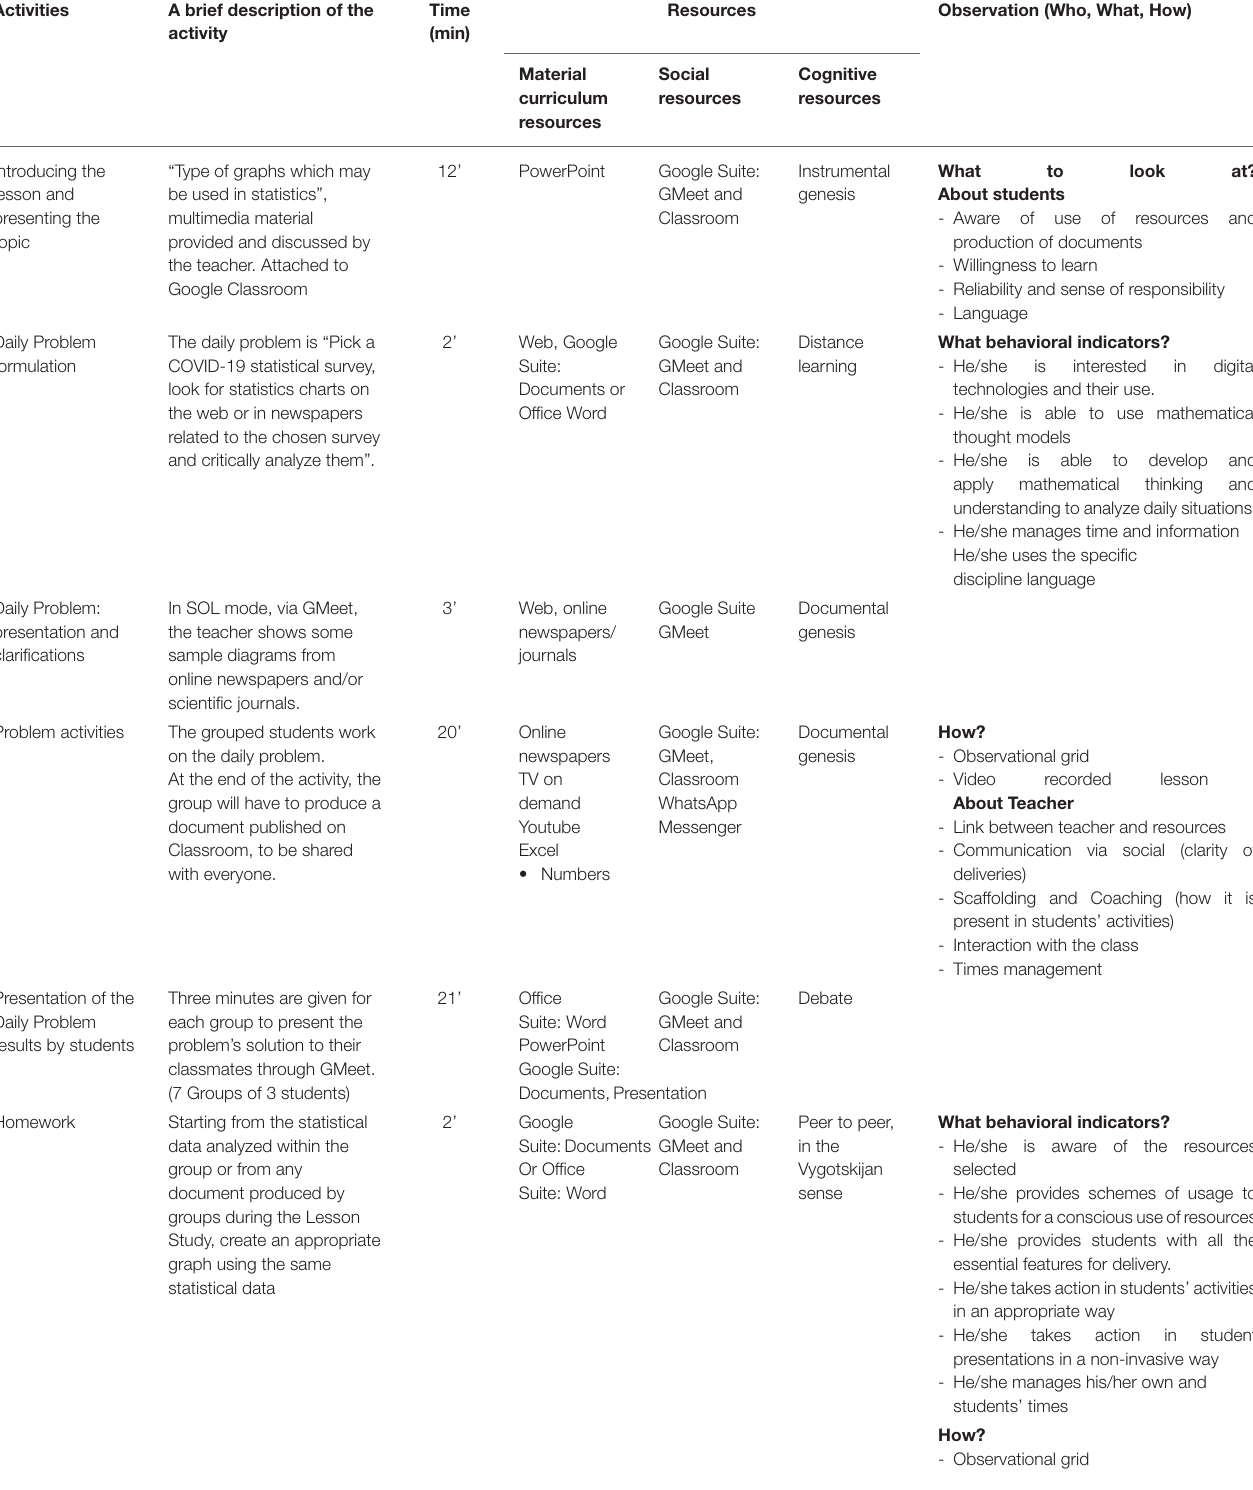
TABLE 1 | Lesson plan of the first Lesson Study